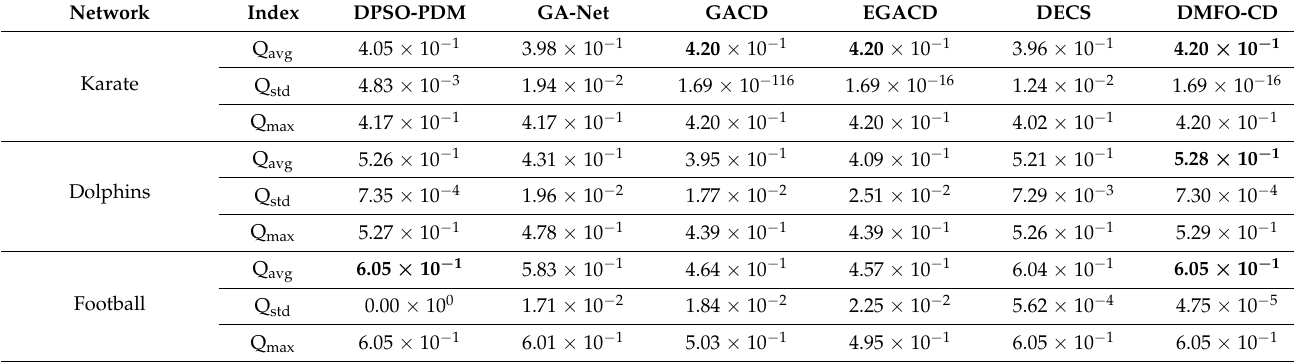
Table 2. The modularity results on eleven